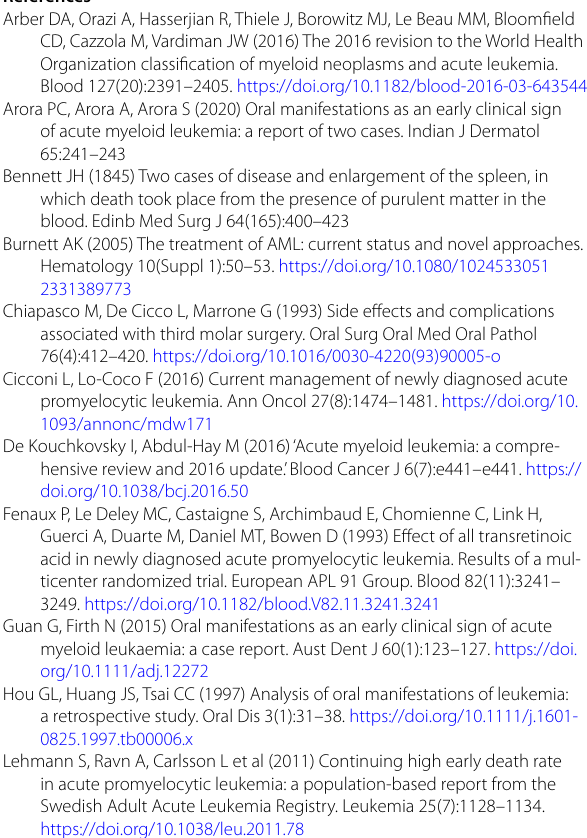
Fig. 2 Diagnostic Bone Marrow Aspirate ( marrow, abnormal promyelocytes with azurophilic granulation, some containing Auer rods